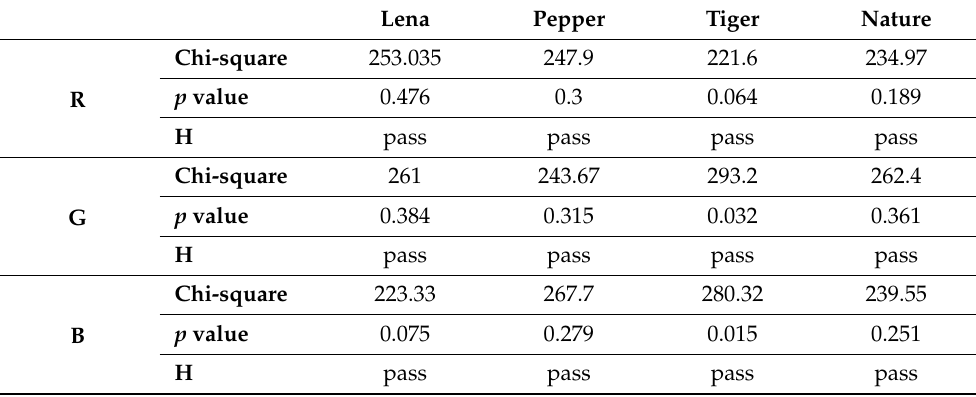
Table 8. Chi-square test results.